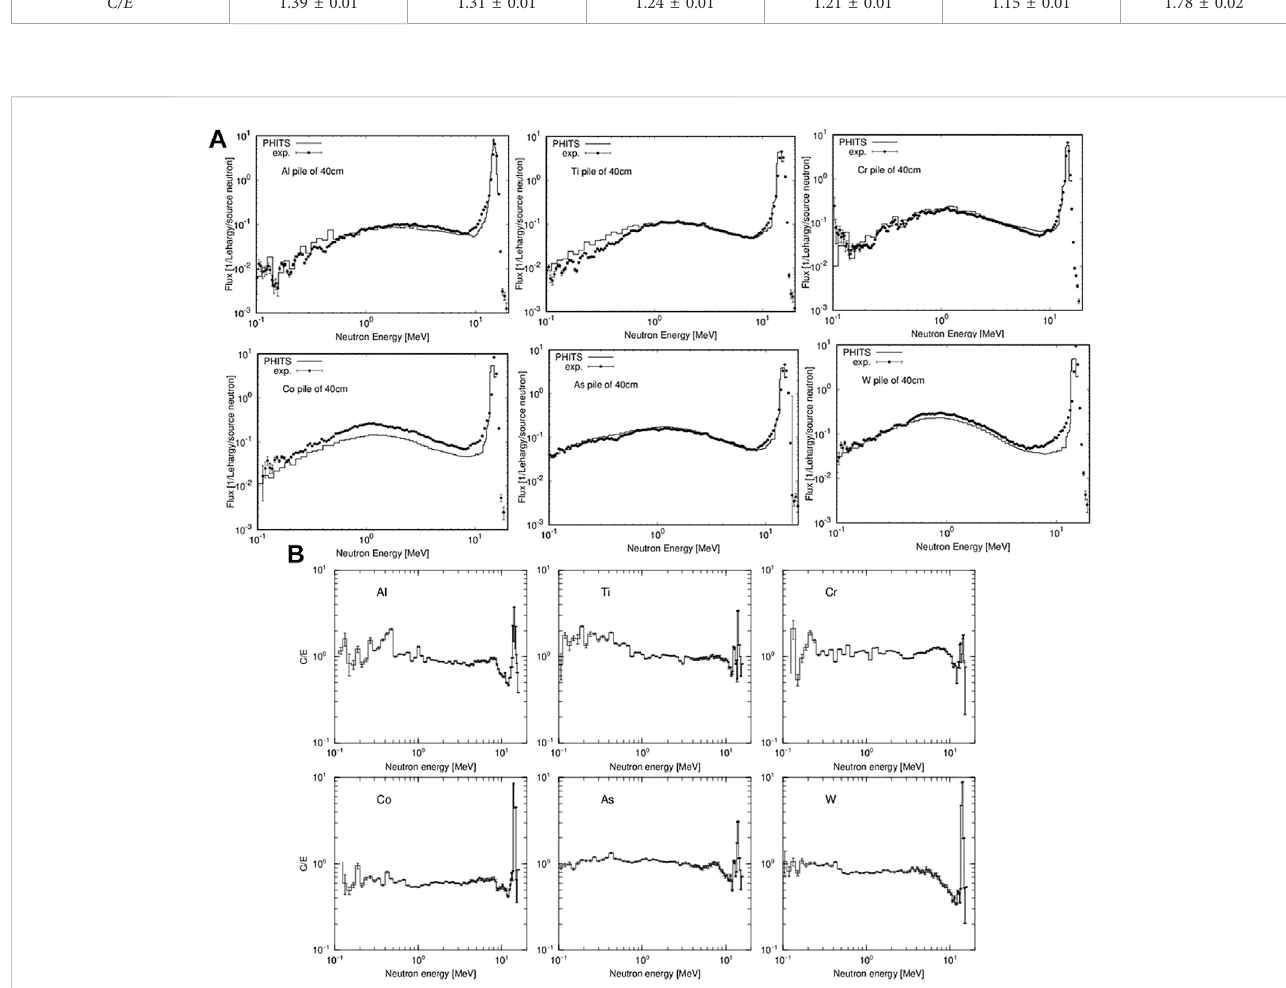
FIGURE 7 (A) Neutron energy spectra from Al, Ti, Cr, Co, As, and W piles for a 250-keV D-T neutron source. The experimental errors include only the statistical deviation of neutrons in the measurement. (B) The ratio of calculation results and experimental data to the neutron energy. Note that there are places where the energy bins in the experimental neutron fl ux plots are different from those in the calculated